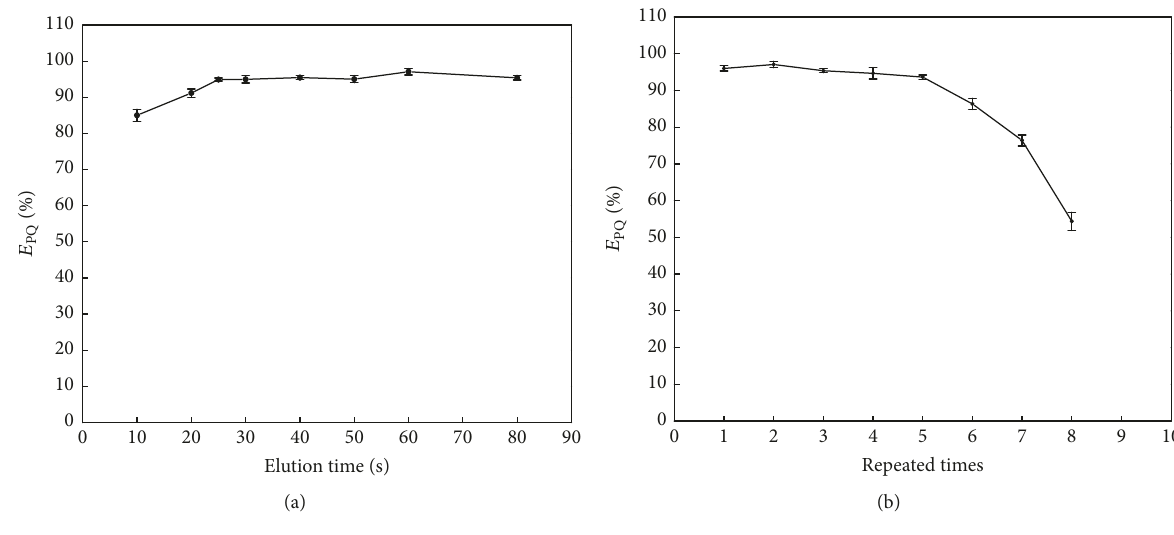
Figure 6: The effect of the elution time and the reusability. Table 2: Comparison of the MSPE + UV method with other analytical techniques for extraction and determination of PQ. Extraction Sample